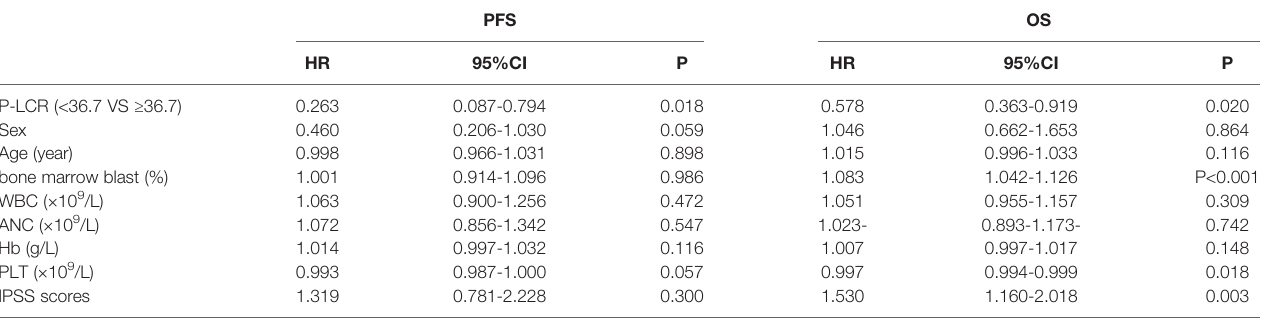
P-LCR (<36.7 VS ≥ 36.7)